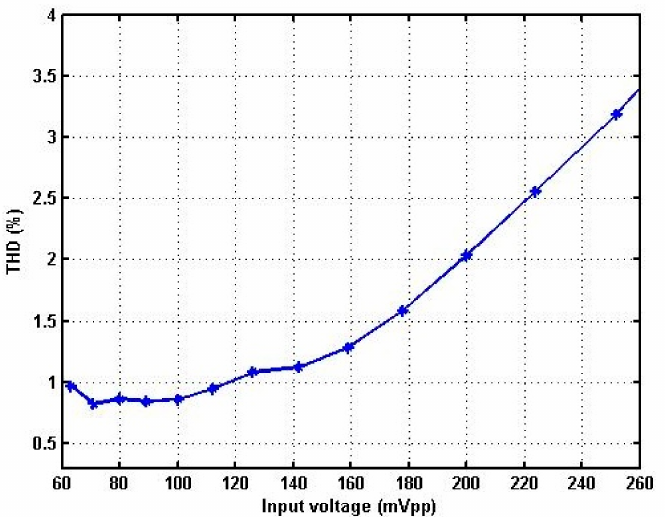
Figure 16. THD analysis results of the NBPF at the output of V BP2 with different input